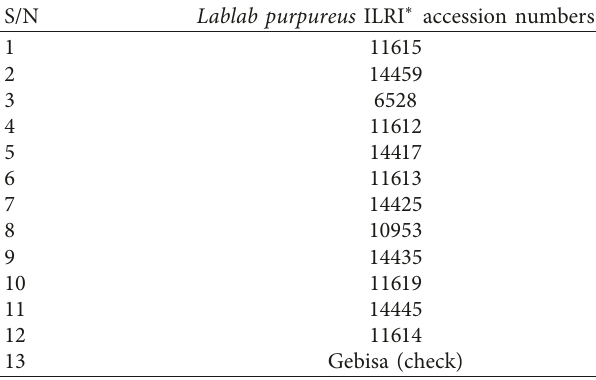
Source: ∗ International Livestock Research Institute,